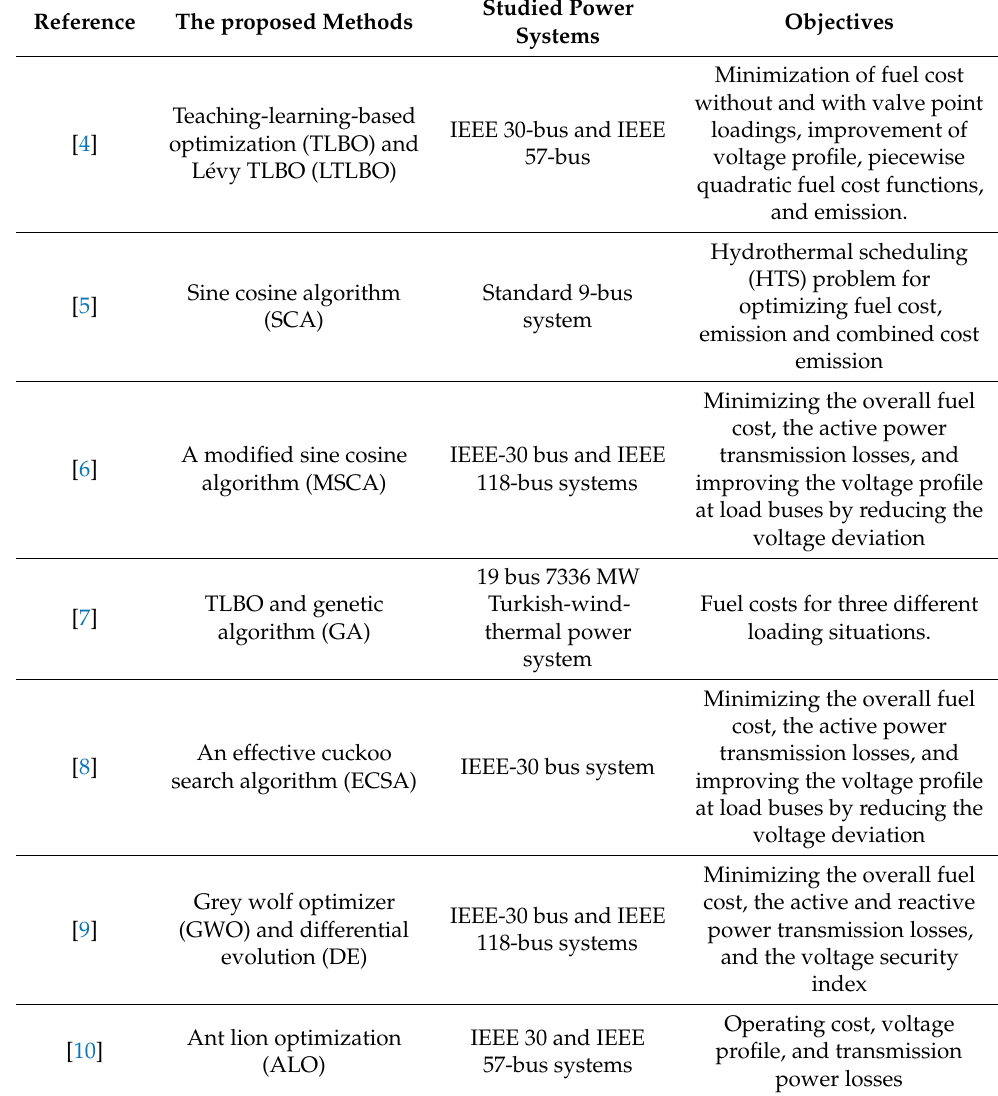
Table 1. Summary of the proposed methods for solving the OPF problems in the recent literature.